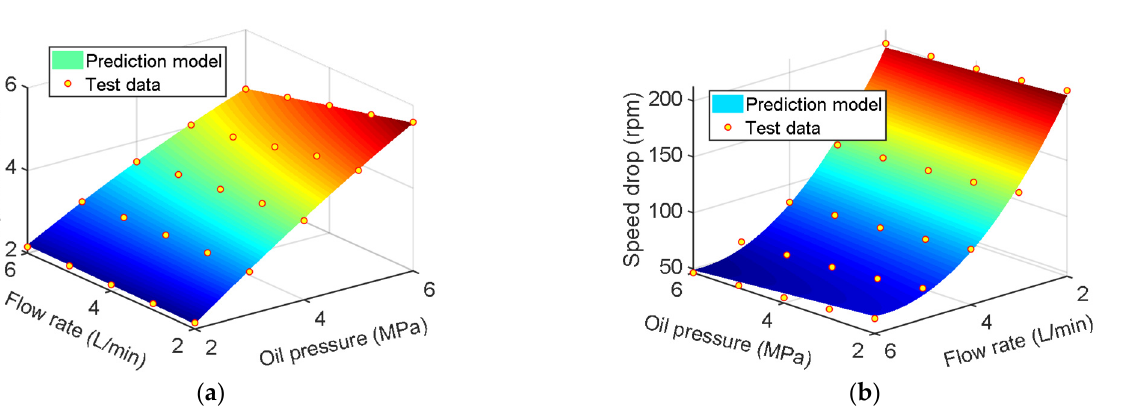
Figure 9. Example of the establishment result of single evaluation index model: ( a ) Dynamic load; ( b ) speed drop.